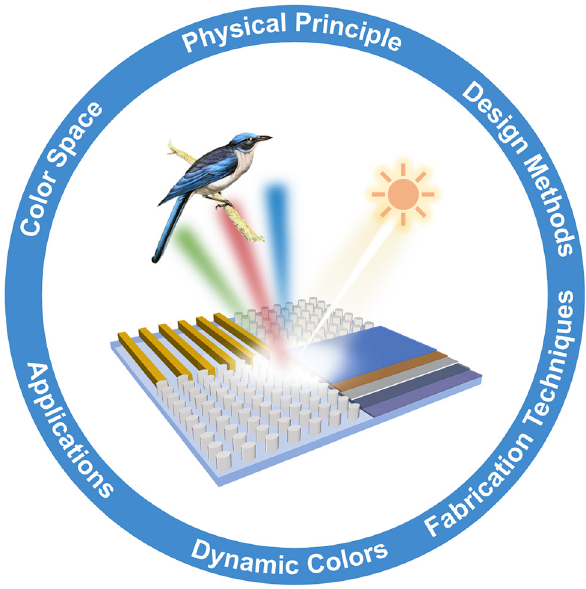
Figure 1: Schematic of structural color generation and key aspects covered by this